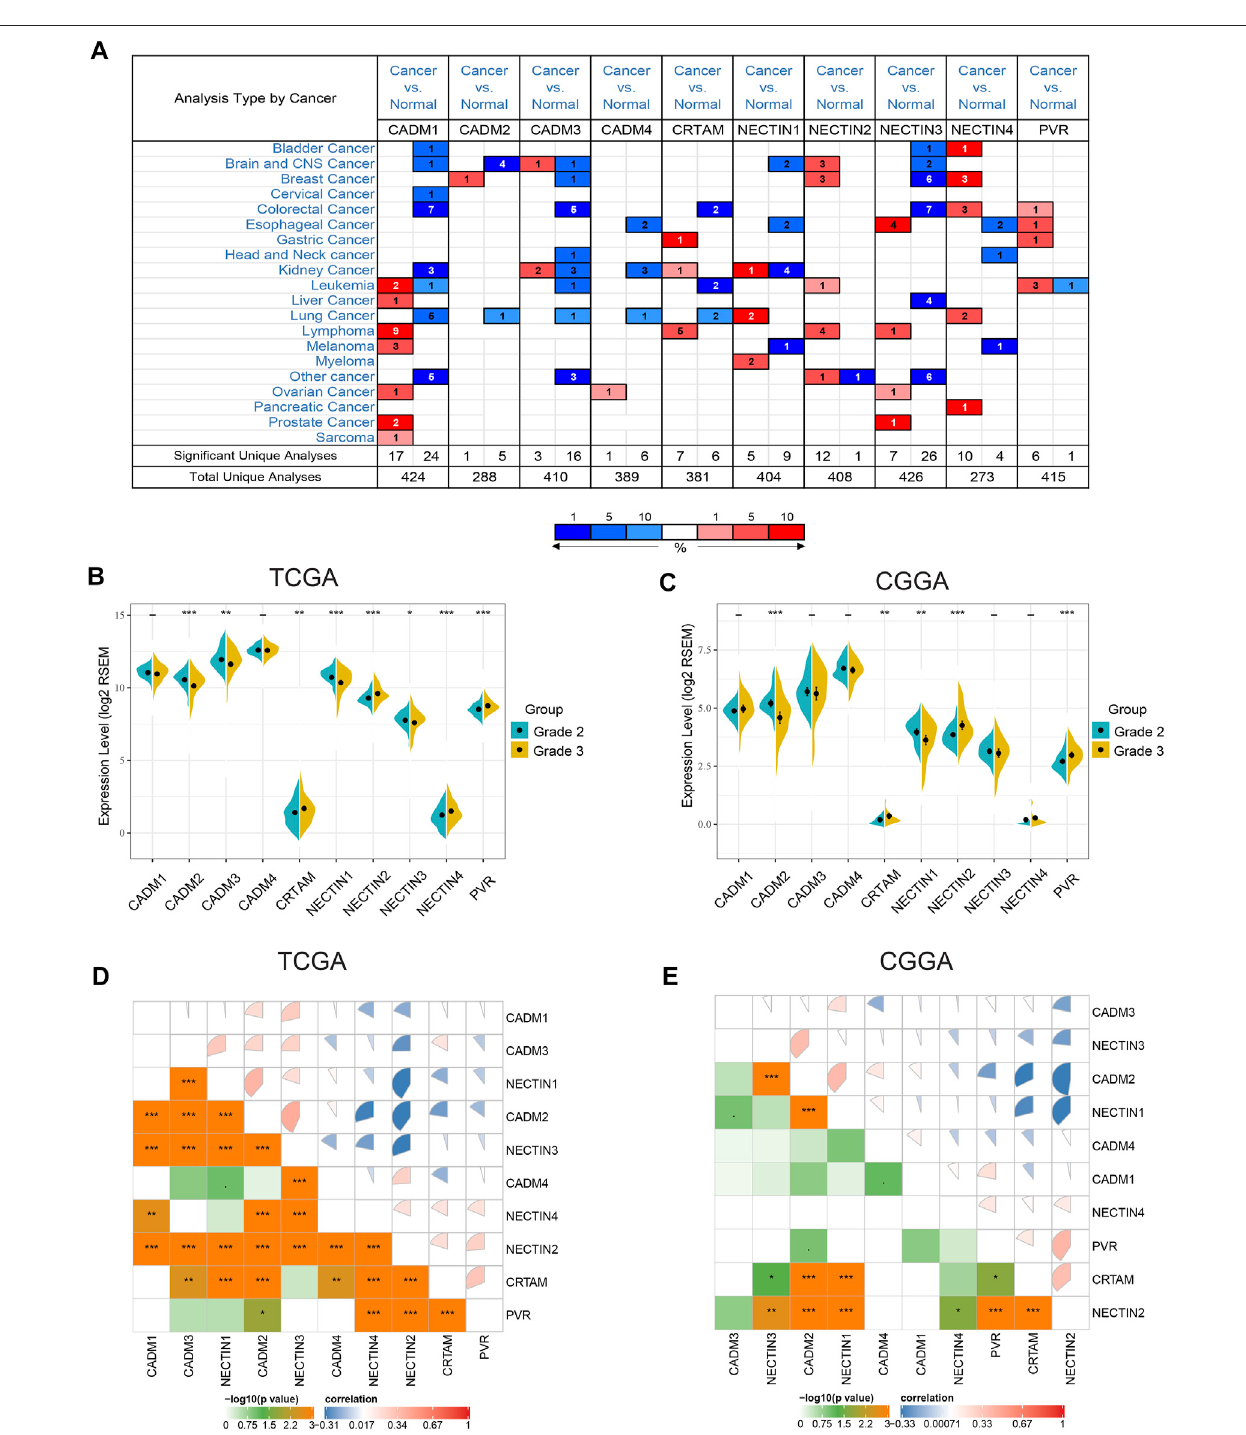
FIGURE 1 | Expression pro fi le of nectin family members and necls in different cancers and LGG (A) . The expression level of nectin family members and necls in multiple types of cancers. Red and blue stand for the numbers of datasets with statistically signi fi cant ( p < 0.05) overexpression and under expression levels of nectin family members and necls, respectively. (B,C) The expression level of nectin family members and necls were differentially in different grades LGG in TCGAB and CGGA (C) . (D,E) Correlation plot among nectin family members and necls in TCGA (D) and CGGA (E) . The color of the pie chart represents the correlation of the expressionoftwogenes(blue:negativelycorrelated,red:positivelycorrelated).Theareaofthecoloredpieisproportionaltothestrengthofmutualcorrelation.Theplotin the lower part represents the Statistical signi fi cance (by Spearman test).